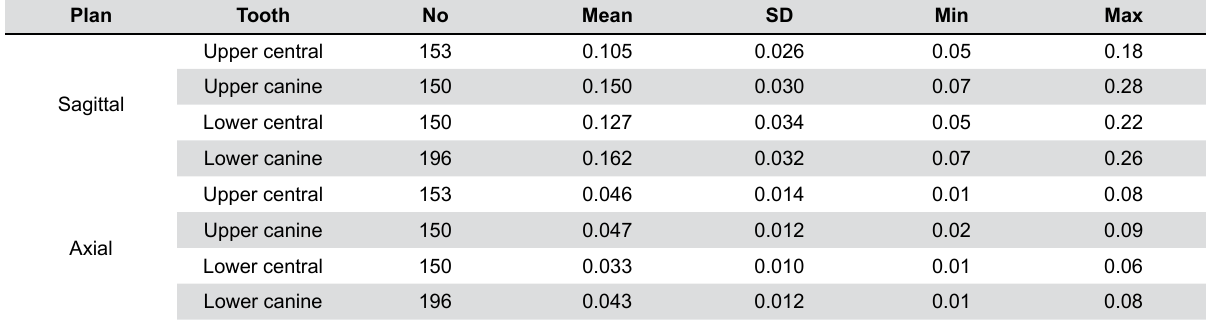
Table 1- Descriptive statistics for the pulp to tooth area ratio in anterior teeth